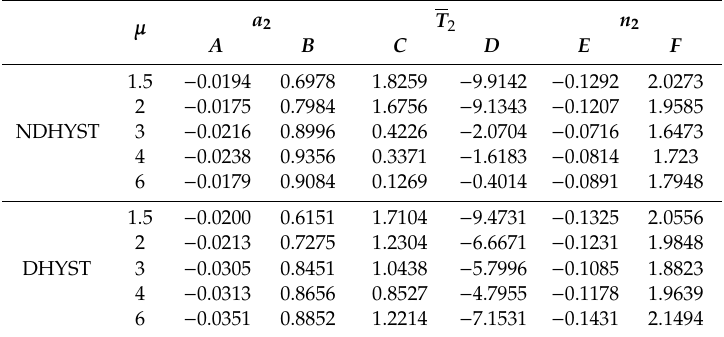
Table A2. Numerical values of the constants involved in the closed-form approximation of the mean plus one standard deviation spectrum of the hysteretic energy reduction factor R Ha (NDHYST: non-degrading hysteretic behavior; DHHYST: degrading hysteretic behavior). µ a 2 T 2